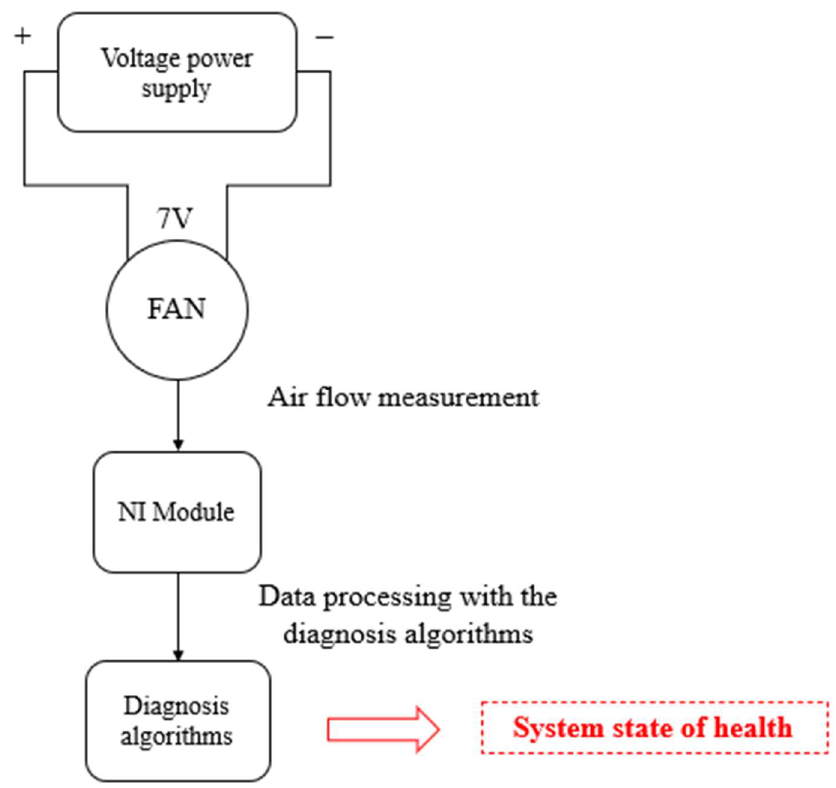
Figure 8. Assembly diagram.